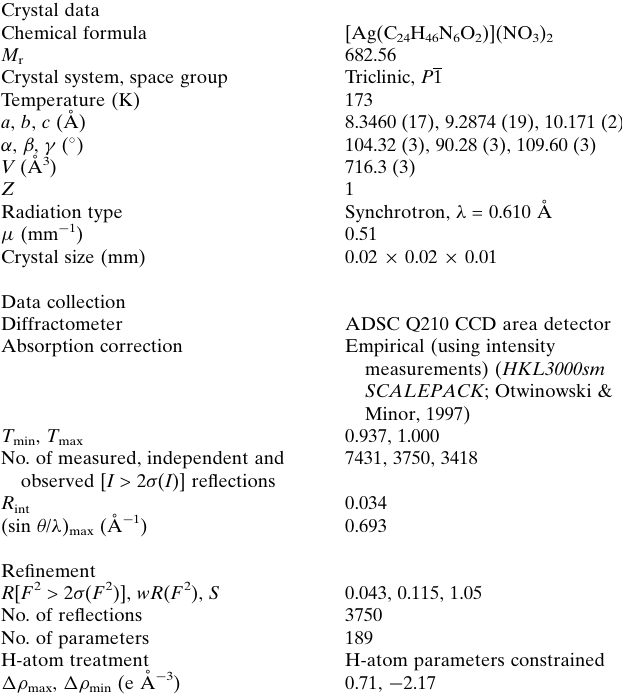
Table 2 Experimental details. Crystal data Chemical